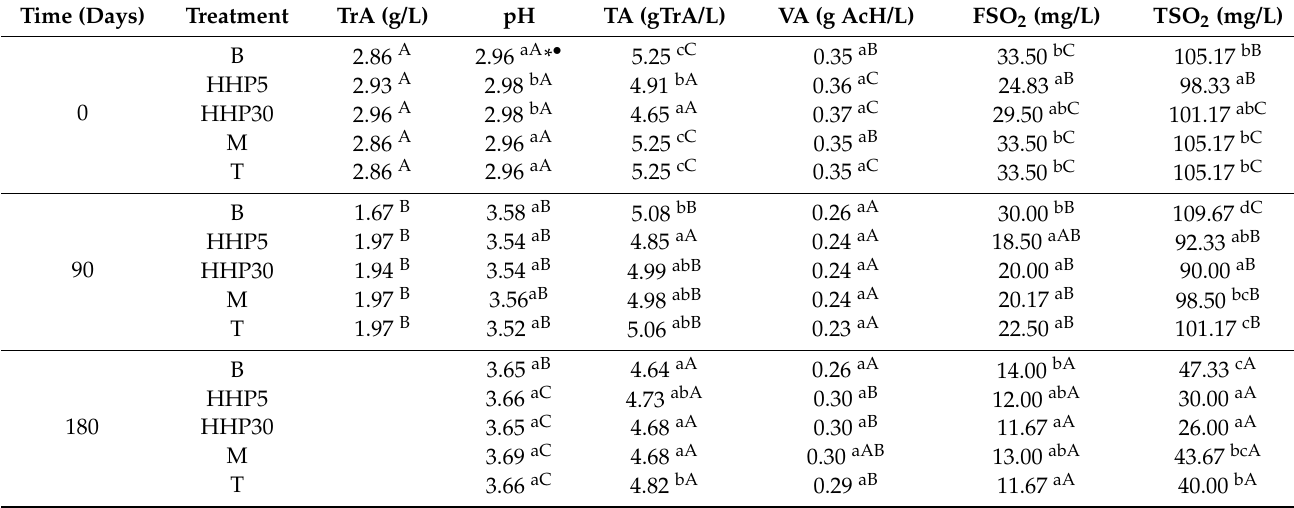
B: Wines bottled without any treatment; HHP5, HHP30: Wines bottled after maceration of holm oak chips (5 g/L) with HHP treatments (400 MPa, 5 and 30 min). M and T: Wines bottled after storage for 45 days in tanks with and without maceration of holm oak chips Chips (5 g/L). TrA: Tartaric acid; TA: Total acidity; VA: Volatile acidity; Ach: Acetic acid; FSO 2 : Free SO 2 ; TSO 2 : Total SO 2 . * Different lower case letters indicate significant differences ( p < 0.05) among the treatments for the same day. • Different capital letters indicate significant differences ( p < 0.05), for the same treatment on different